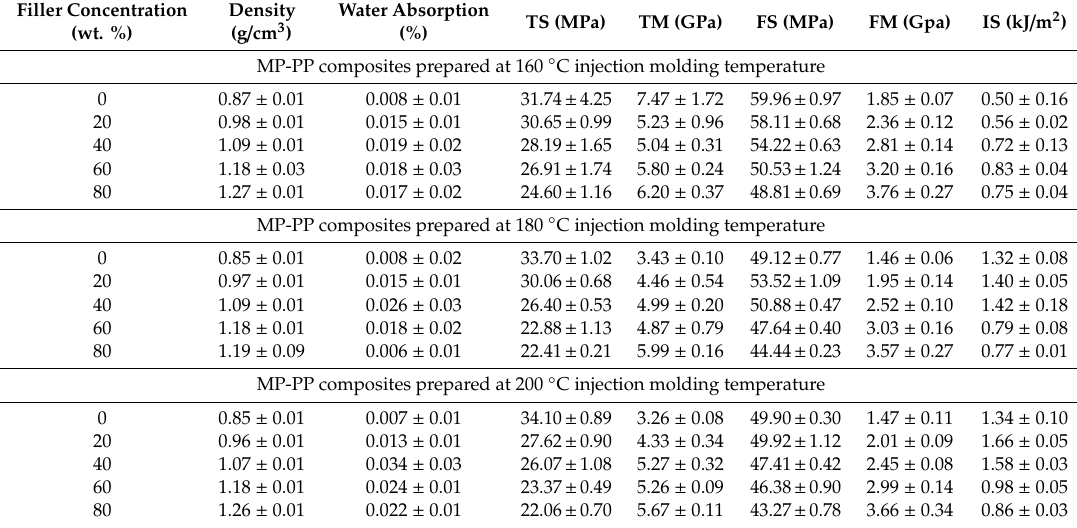
Table 3. Propertiesof MP-PP composites /